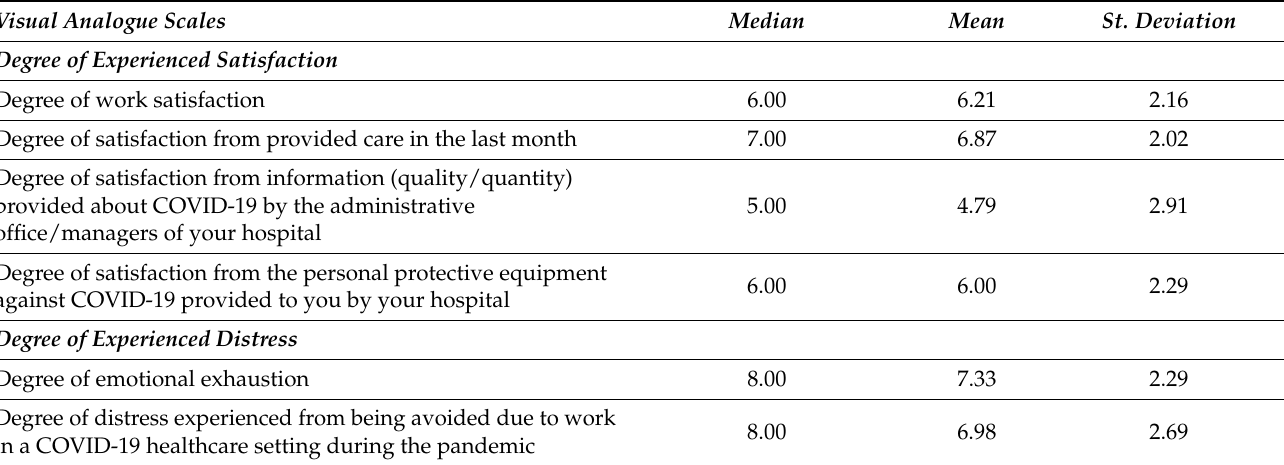
Table 2. The satisfaction and distress that were experienced from work-related factors (N =